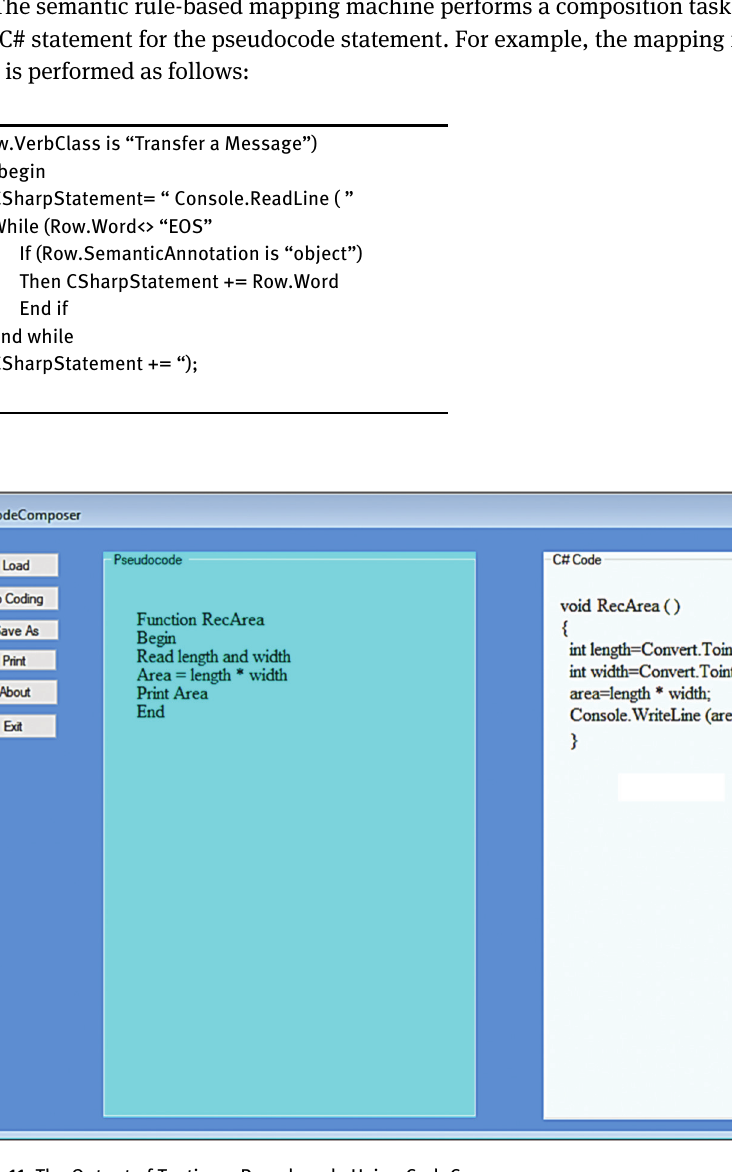
Figure 11: The Output of Testing a Pseudocode Using